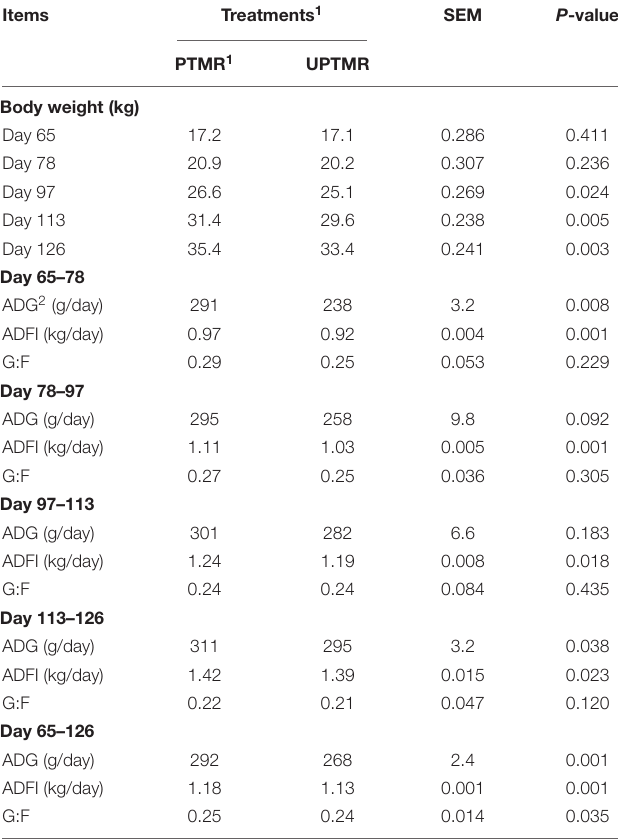
TABLE 1 | Effects of dietary types on productivity of fattening lambs.